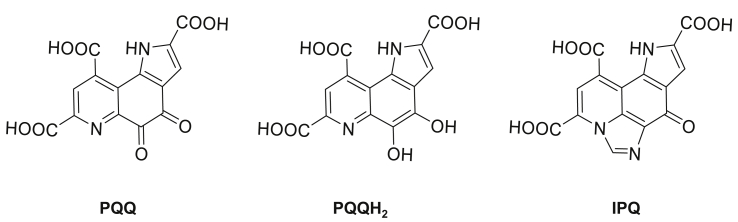
Comparison of structures of PQQ, PQQH2 and IPQ.